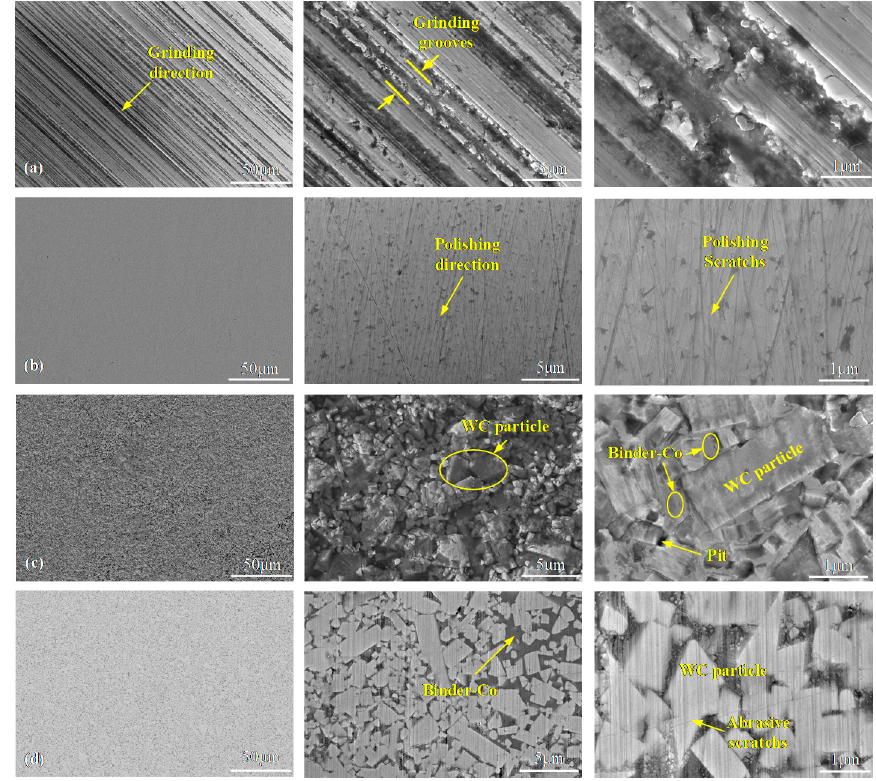
Figure 6. SEM images of WC-0Co and WC-12Co before polishing and after fine polishing in three different magnifications. ( a ) WC-0Co before polishing; ( b ) WC-0Co after fine polishing; ( c ) WC-12Co before polishing; ( d ) WC-12Co after fine polishing.